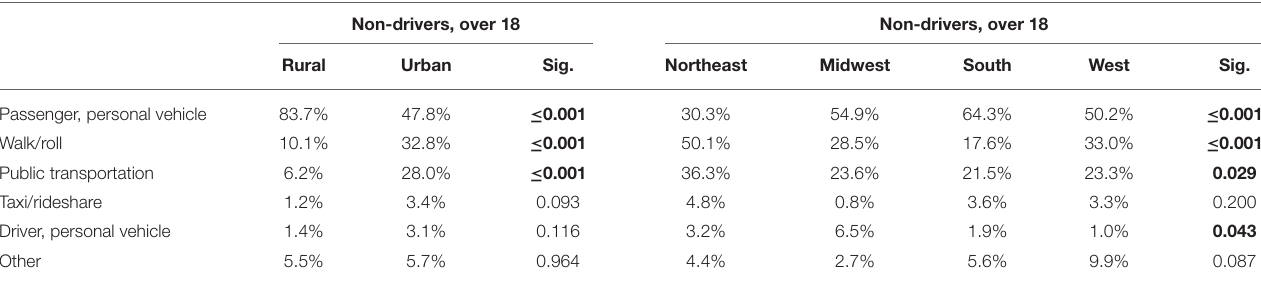
TABLE 3 | Transportation modes used by non-drivers with disabilities, by rural/urban and region (weighted). Non-drivers, over